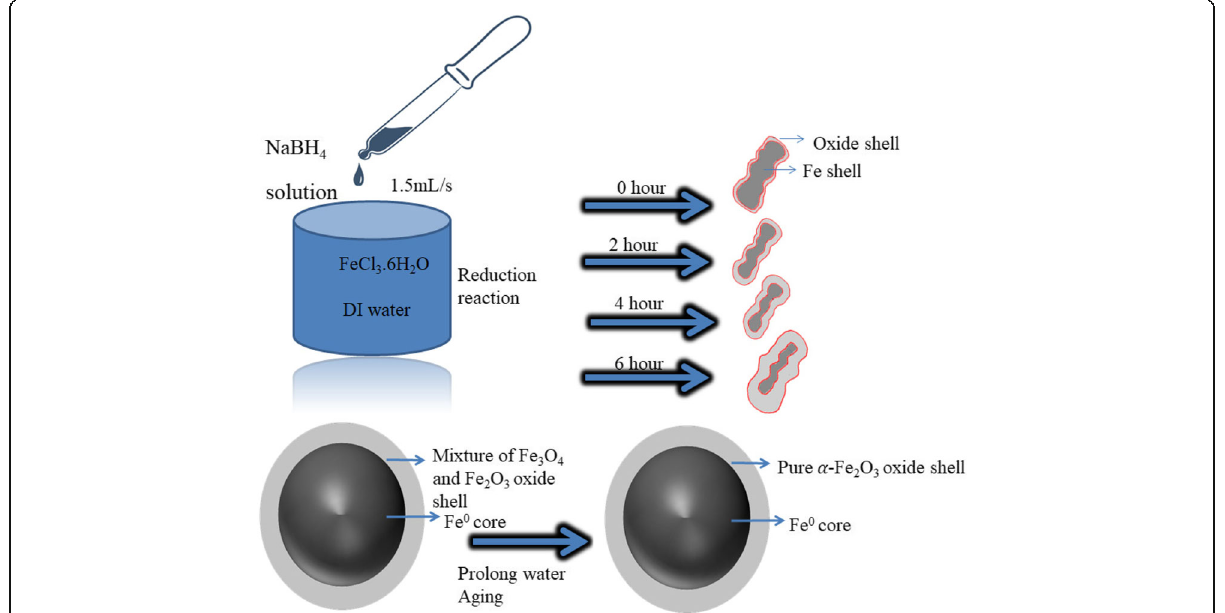
Fig. 2 Schematic illustration of synthesis and formation of core-shell Fe